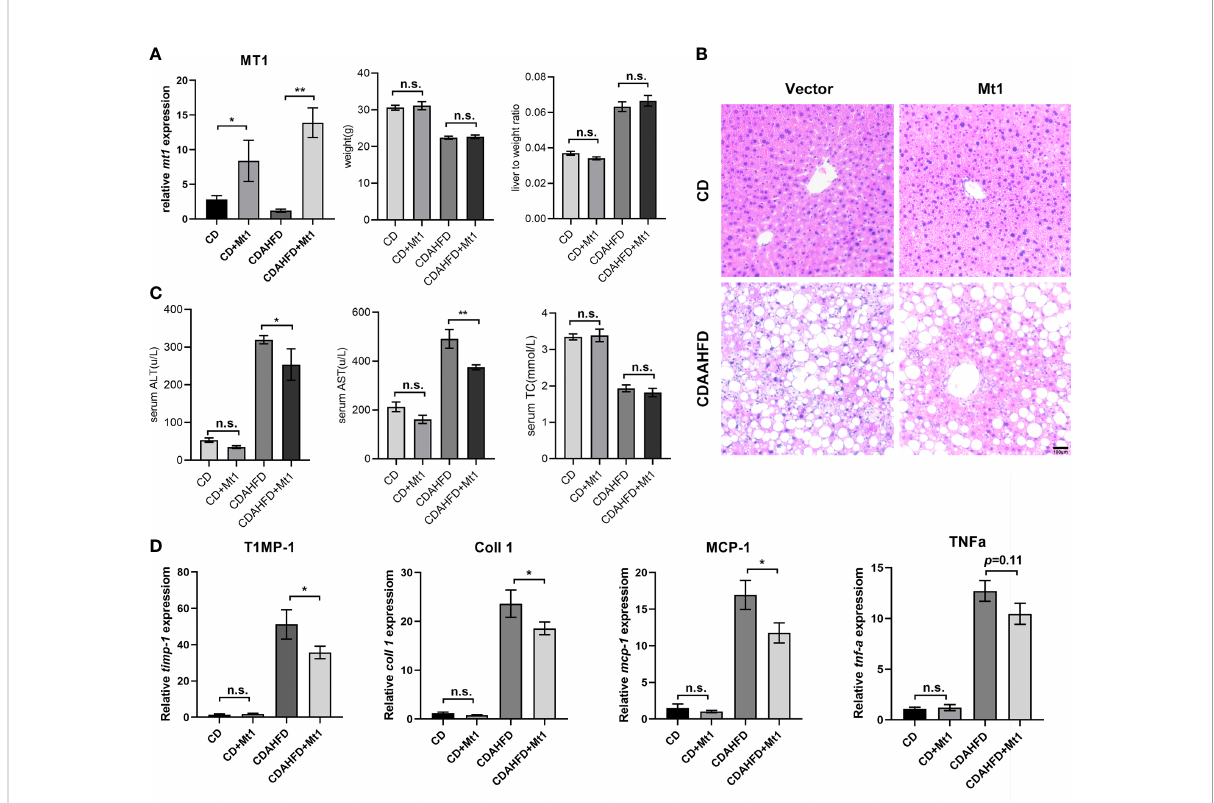
FIGURE 5 MT1 improves liver fi brosis in CDAAHFD mouse model. (A) Expression of Mt1 measured by RT-PCR and weight, and liver-to-weight ratio of each group of mice. (B) H&E staining of liver sections. (C) Serum ALT, AST, and TC of four groups of mice. (D) Expression of Timp-1 , Coll1 , Mcp1 , and Tnf a measured by RT-PCR from CD, CD+Mt1, CDAHFD, and CDAHFD+Mt1 mice. N = 5 mice per group, and all data are shown as mean ± SEM. * p < 0.05, ** p < 0.01. “ n.s. ” means no signi fi cance. ALT, alanine transaminase; AST, aspartate transferase; TC, total